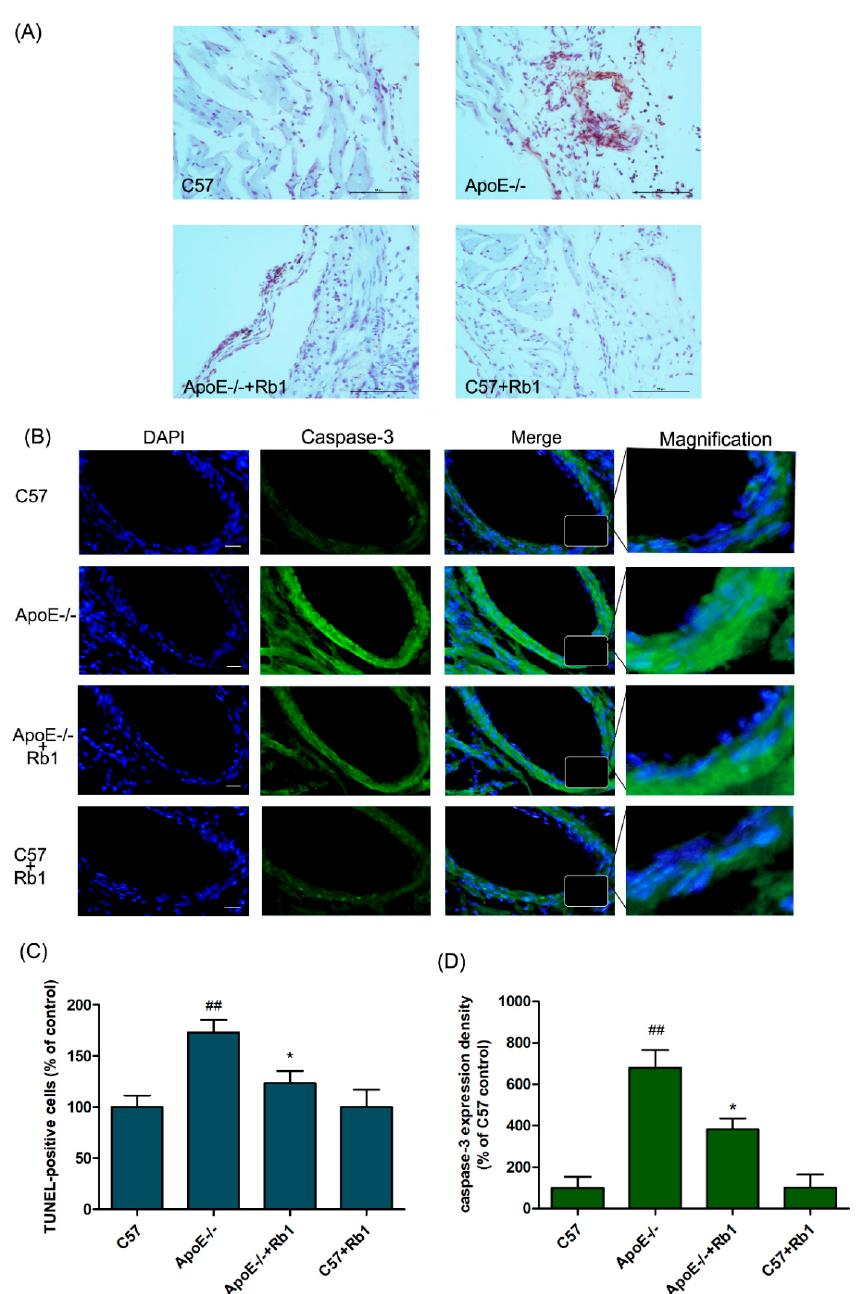
Figure 5. Rb1 attenuated the percentage of apoptotic cells in the aorta of ApoE-/- mice. ( A ) TUNEL staining in the aorta for each group; scale bar, 100 μ m. ( B ) Caspase-3 as expression detected by immunohistochemical staining and DAPI; scale bar, 80 μ m. ( C ) quantitative analysis of the percentage of TUNEL-positive cells. ( D ) Quantitative analysis of cleaved caspase-3 expression. The data are expressed as the mean ± the standard error (SE) of the mean in each group ( n = 3). ## p < 0.01 vs. C57 control; * p < 0.05 vs. ApoE-/- model.